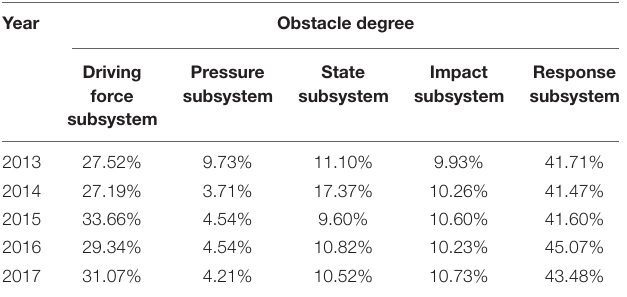
TABLE 5 | The Subsystem obstacle degree of sports regional development resilience in China from 2013 to 2015.